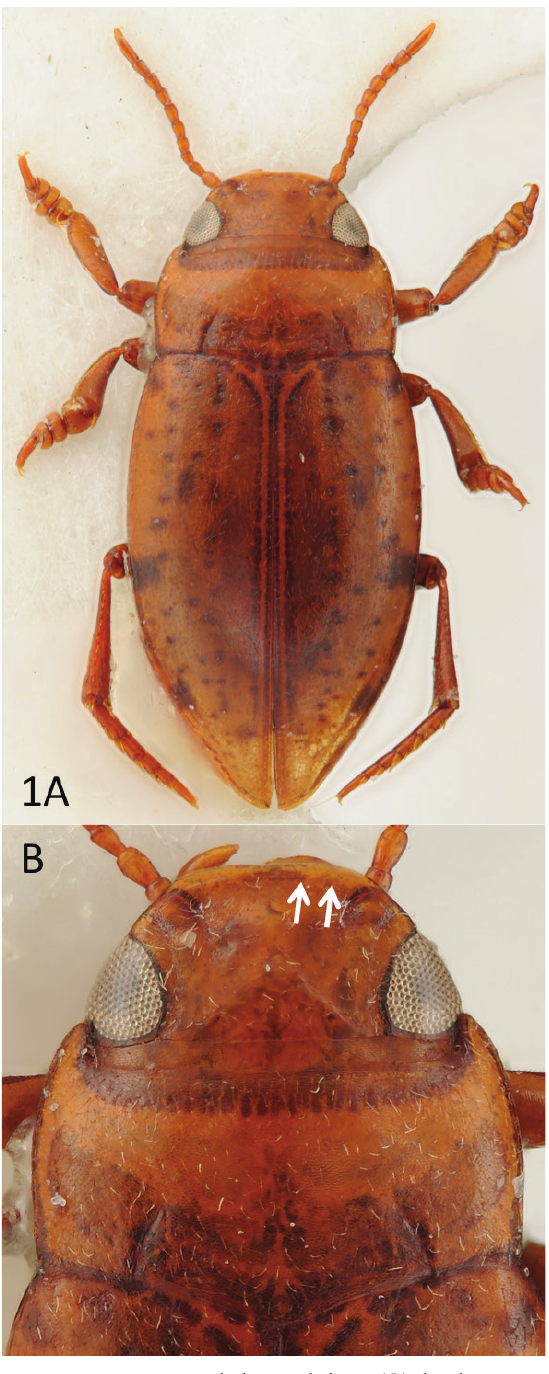
Figure 1. Rompindessus jenisi gen. et sp. n., holotype, habitus ( A ), head, pronotum and base of elytra ( B ). White arrows point to the thick anterior bead of